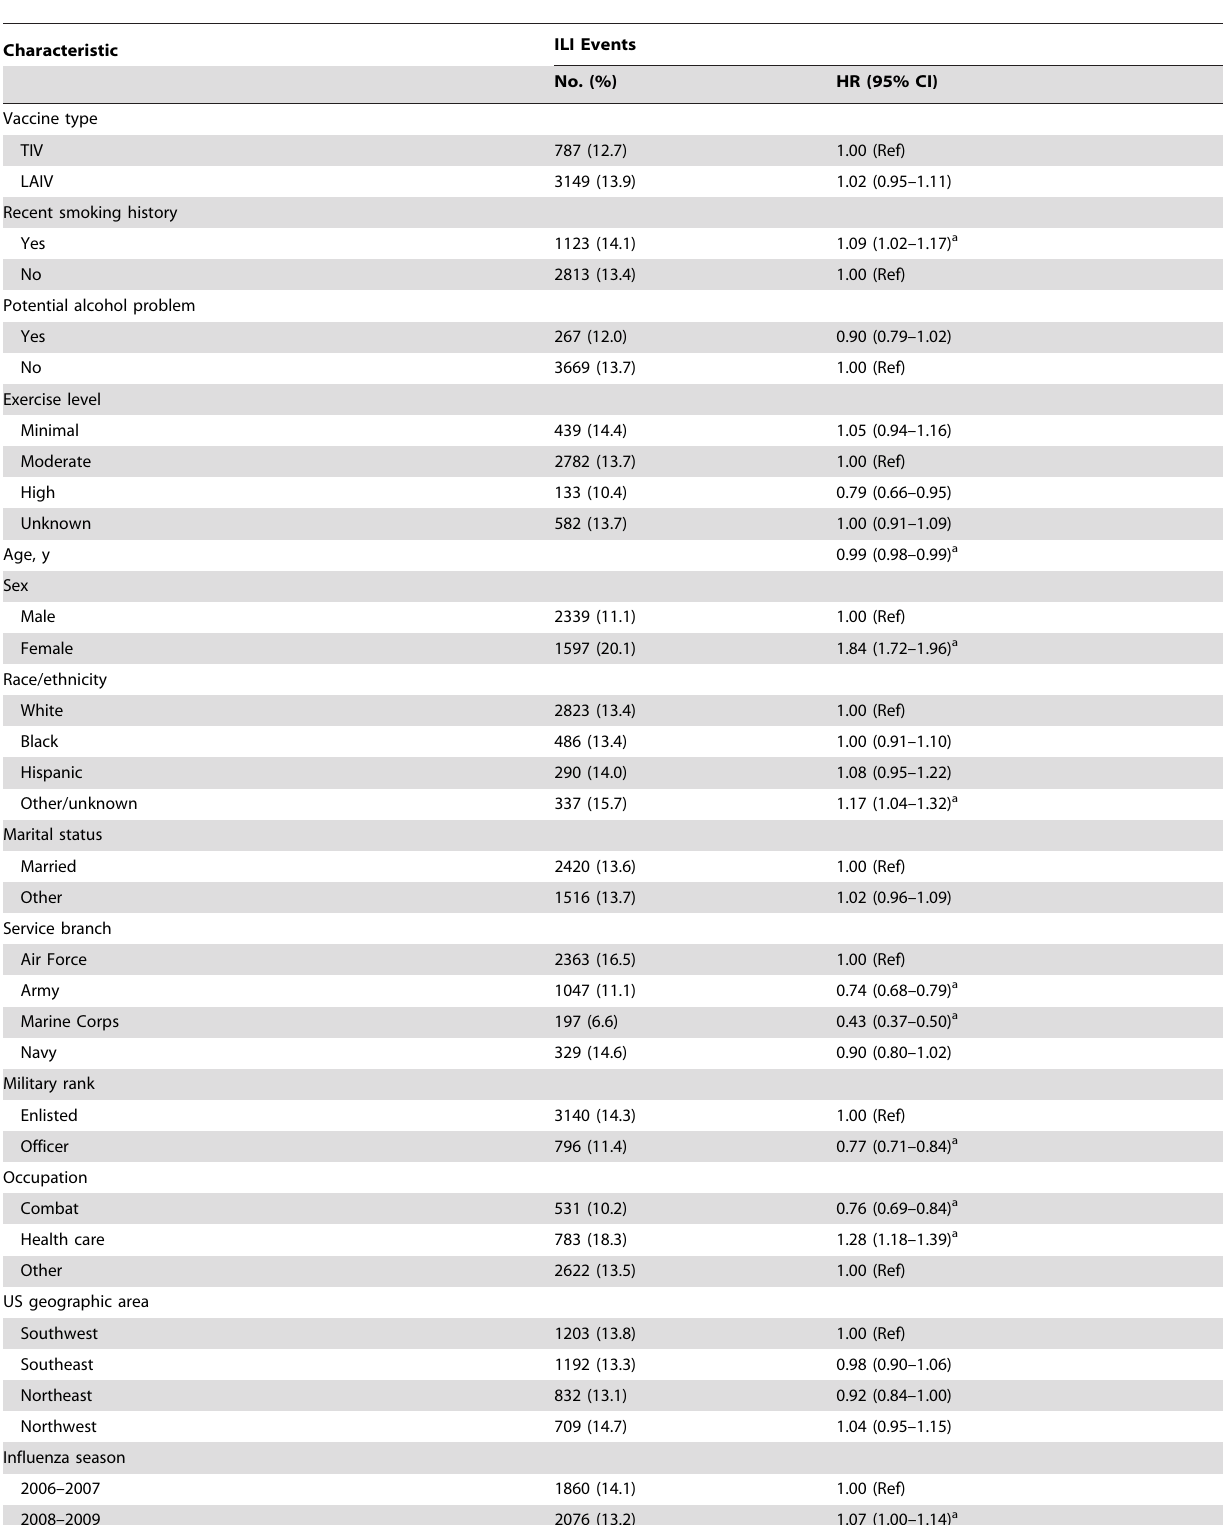
Table 3. Univariable Hazard Risk Ratios for ILI Among US Service Members, 18–49 Years of Age, During 2006/2007 and 2008/2009 Influenza